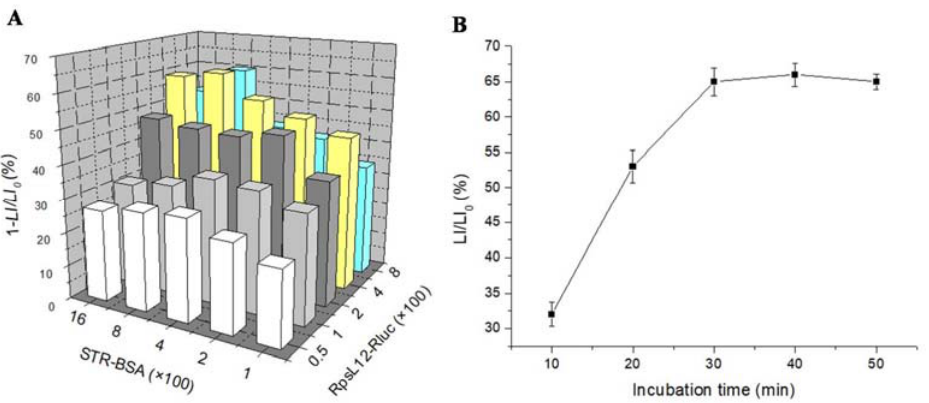
Figure 6. Results for the optimization of ( A ) the concentrations of RpsL12–Rluc and STR–BSA, and ( B ) incubation time (STR 100 ng/mL). ( B ) incubation time (STR 100